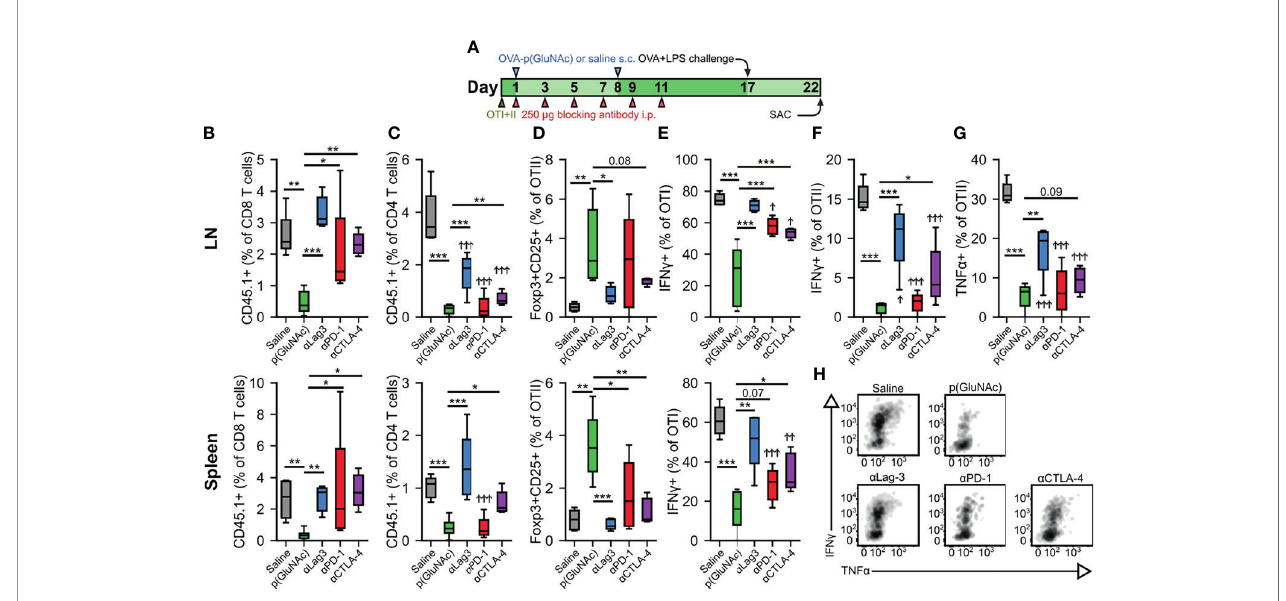
FIGURE 4 | (A – F) CD45.2 + mice that had received an adoptive transfer of 1x10 6 of both OTI (CD45.1 + CD3 + CD8 + ) and OTII (CD45.1 + CD3 + CD4 + ) T cells via i.v. injection, were treated on days 1 and 8 with saline, or 20 m g of OVA-p(GluNAc) s.c. in all four hocks (5 m g per hock). On days 1, 3, 5, 7, 9 and 11, mice were also treated with 250 m g of either a Lag-3, a PD-1 or a CTLA-4. On day 17, mice were given a s.c. OVA+LPS challenge, and were sacri fi ced 5 days later to evaluate the OTI and OTII T cell phenotype in the dLNs and spleen. (B) OTI CD8 + T cells recovered from dLNs (top) and spleen (bottom). (C) OTII CD4 + T cells recovered